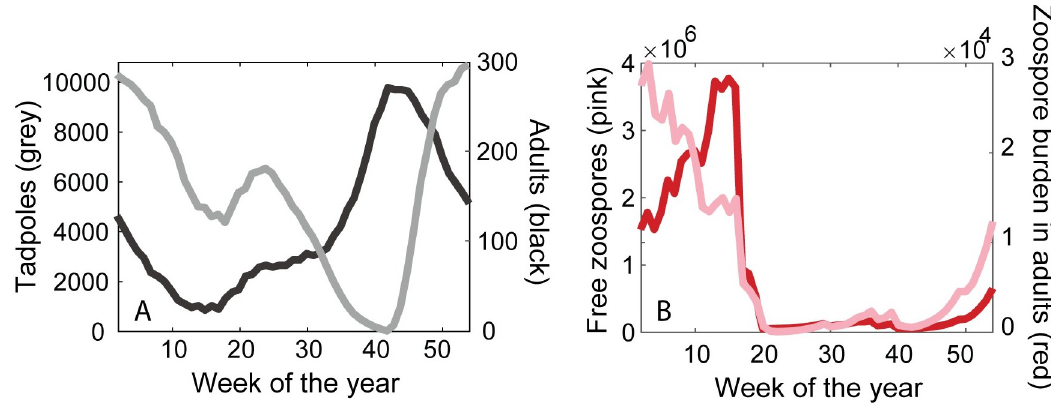
Fig 3. Yearly dynamics of the A. cruciger – Bd interaction. Tadpoles and adults can get infected but only adults can develop lethal chytridiomycosis. (A) The number of tadpoles and adults. (B) Number of free zoospores in the environment and the Bd burden in